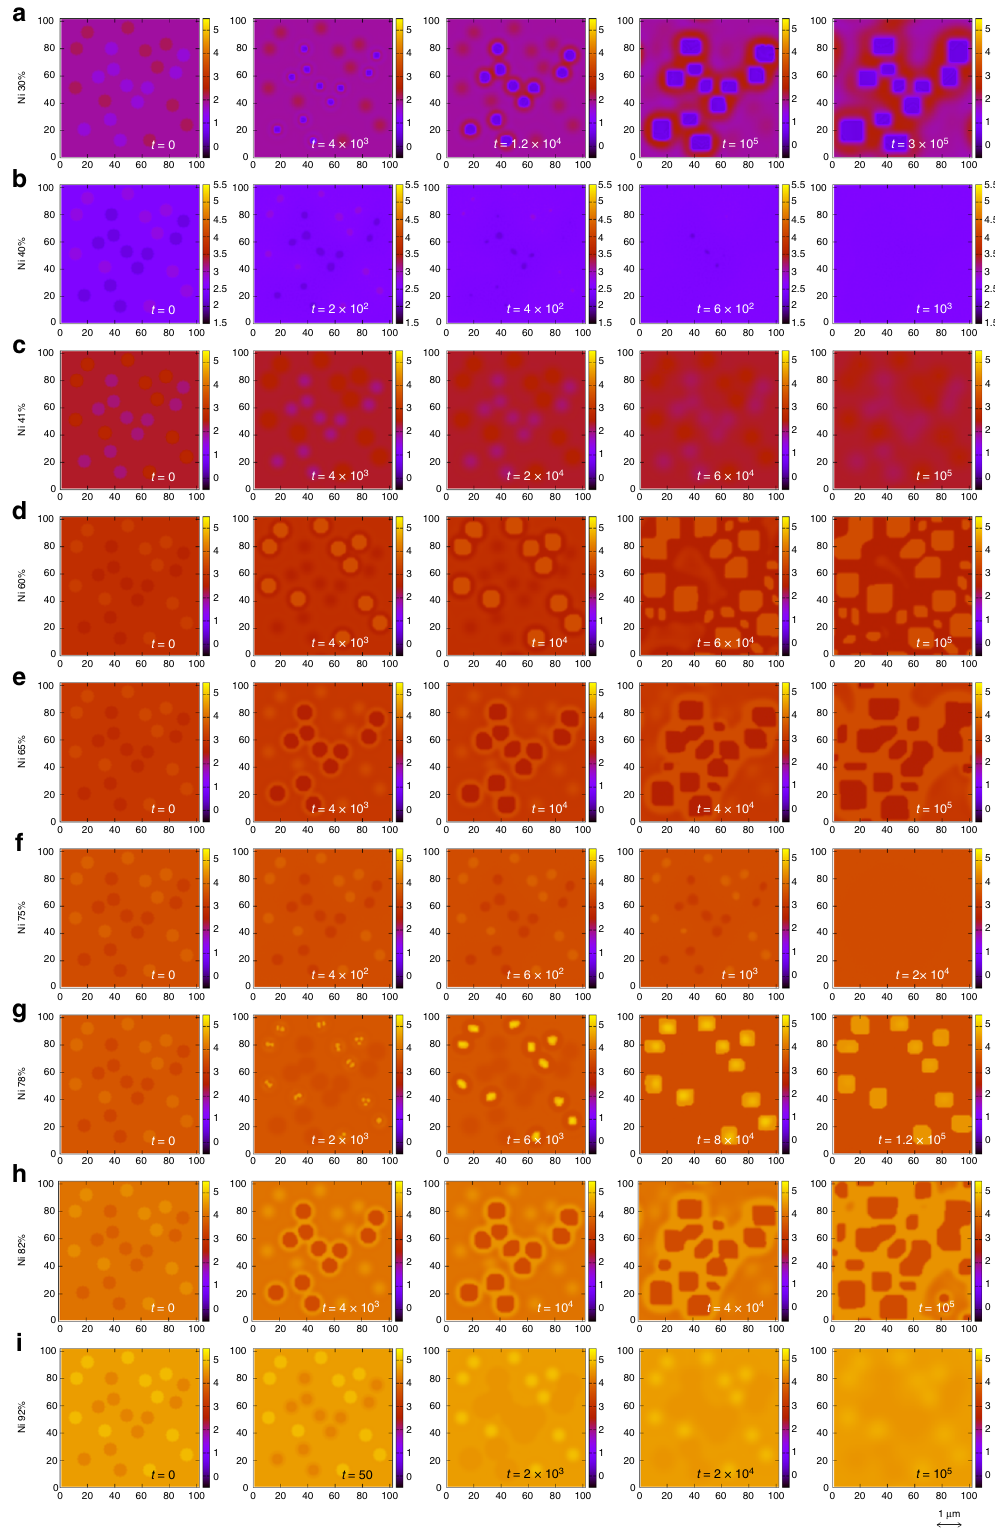
Fig. 6 Time evolution of microstructure in various alloy compositions. Snapshots of phase fi eld simulation for φ Ni at various times for a Ni 1.2 Al 2.8 , b Ni 2 Al 3 , c Ni 1.64 Al 2.36 , d Ni 2.4 Al 1.6 , e Ni 2.6 Al 1.4 , f Ni 3 Al, g Ni 3.12 Al 0.88 , h Ni 3.28 Al 0.72 , and i Ni 3.68 Al 0.32 . The corresponding values of Ni % is written for each row and the simulation time is shown in the inset of each plot. The length scale, given here is a guideline for the readers to have a rough estimation and obtained by comparing with the microstructures as in ref.